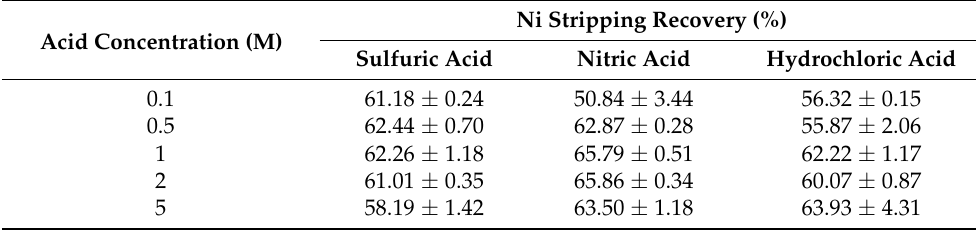
Table 11. Ni stripping recovery according to mineral acid type and acid concentration (O/A 1, feed organic LIX ® 84-I 10% v / v , Ni 4.2